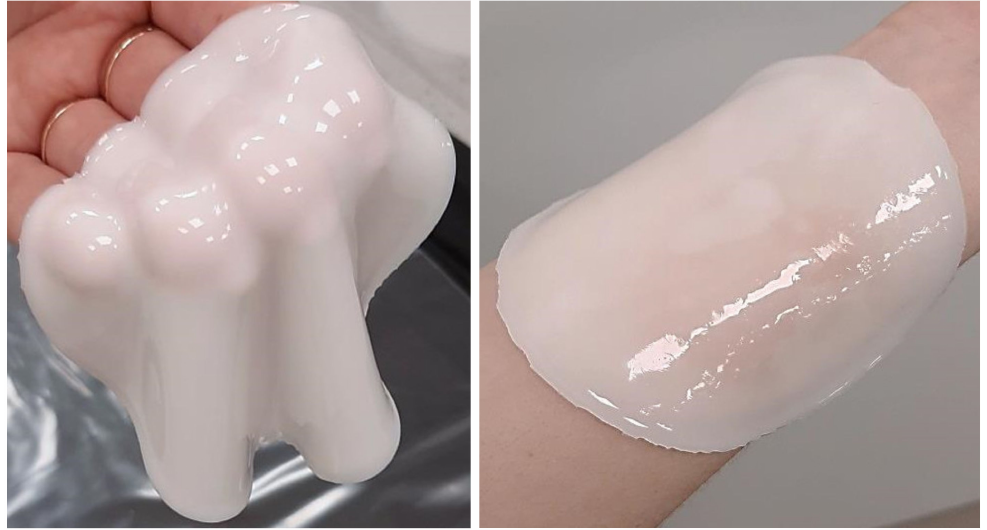
Figure 1. Example images of obtained